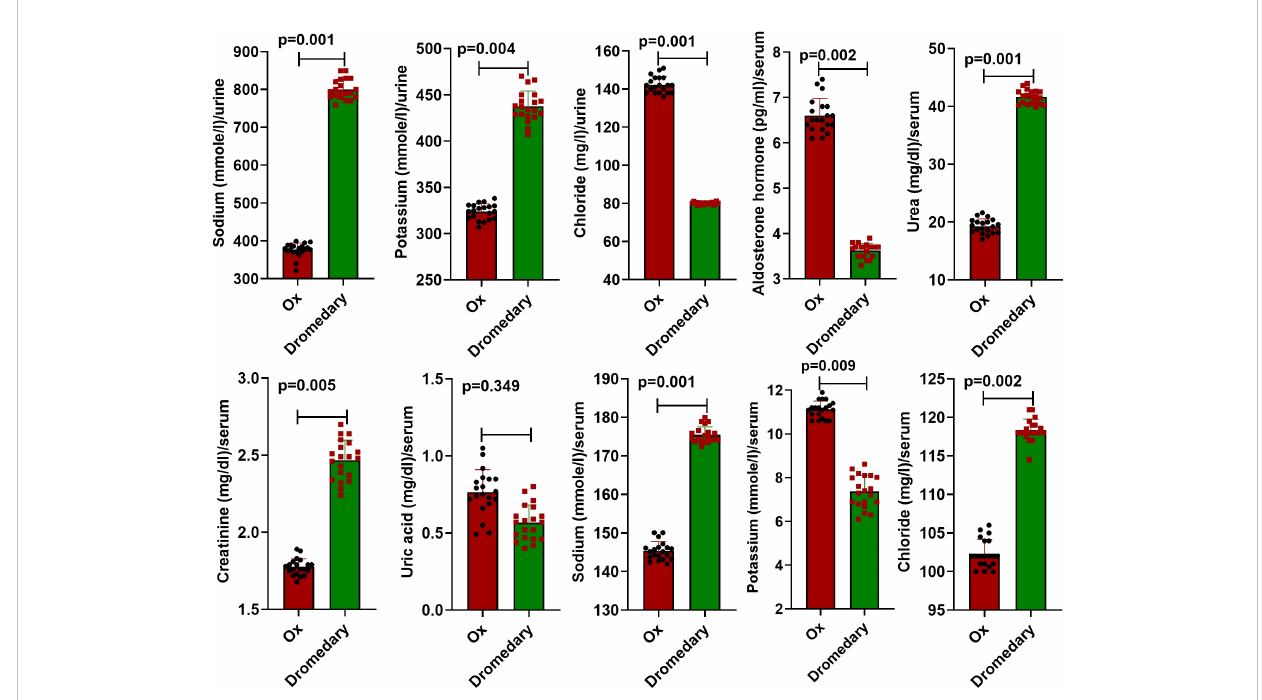
FIGURE 1 Biochemical characteristics of the urine and serum in oxen and dromedaries (n = 20 each). Data are shown as Means ±